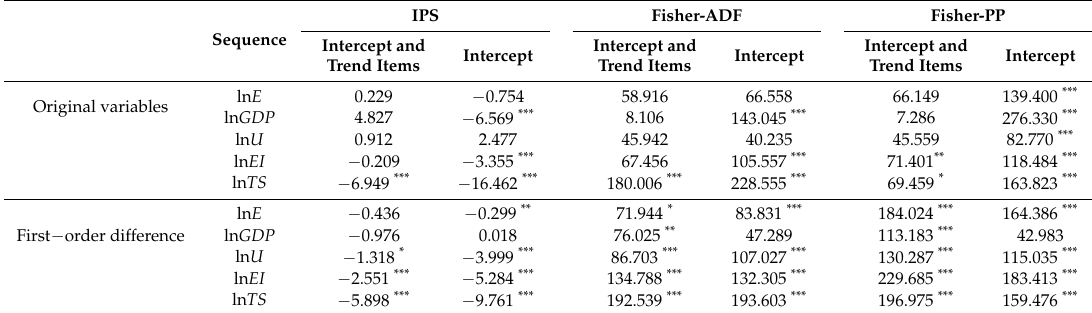
Table A2. Unit root test results.